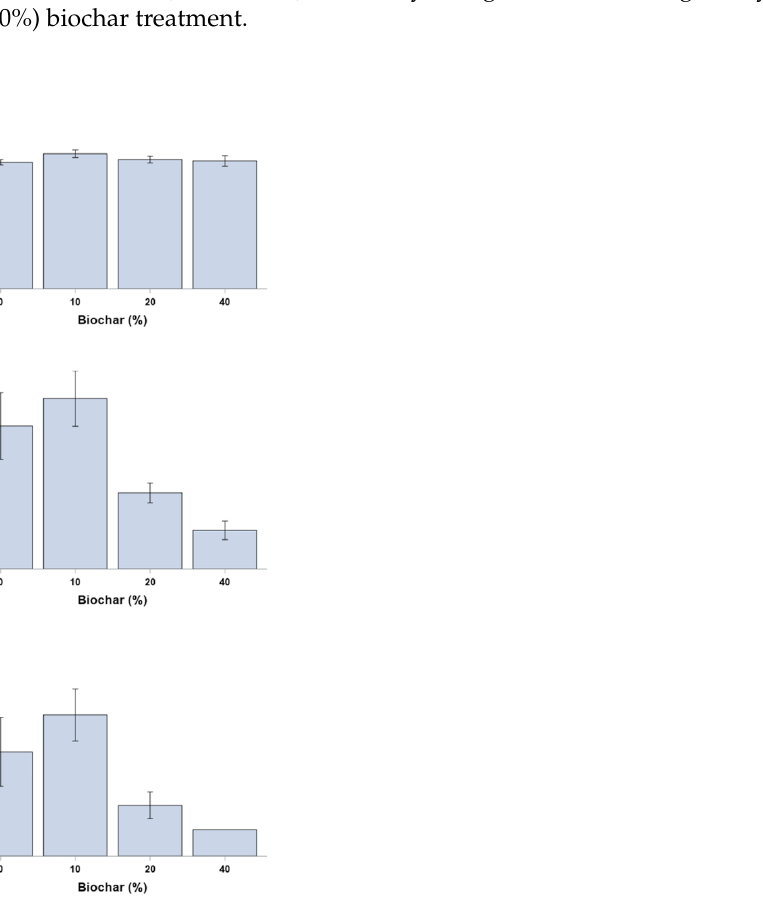
Figure 4. Mean larval weights (g ± SEM) of O. pseudotsugata larvae reared on synthetic diet with biochar incorporated into diet at four rates (0, 10, 20 and 40% (by volume)) of the diet mixture. Initial weights were taken at ( A ) day 0 for all second instar larvae prior to random assignment to each diet-biochar treatment, then again at ( B ) day 12 and ( C ) day 24 for surviving larvae. Only 1 larva survived to day 24.